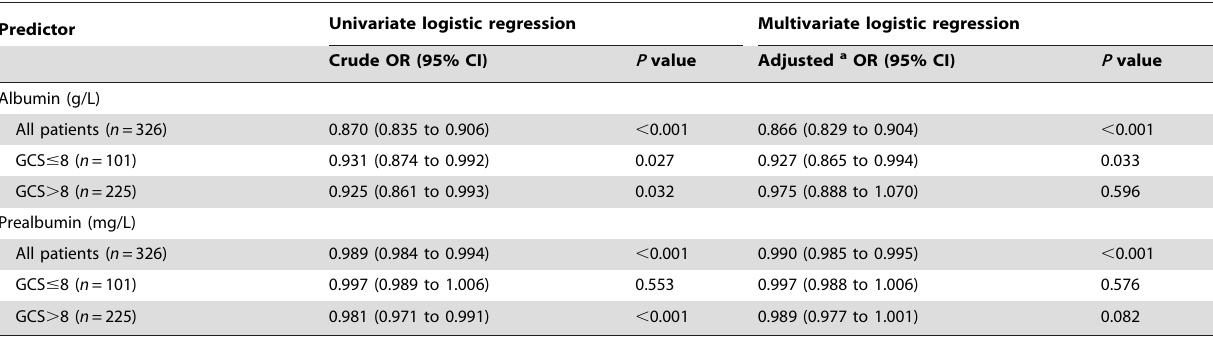
Table 2. Logistic regression analyses for predictors.